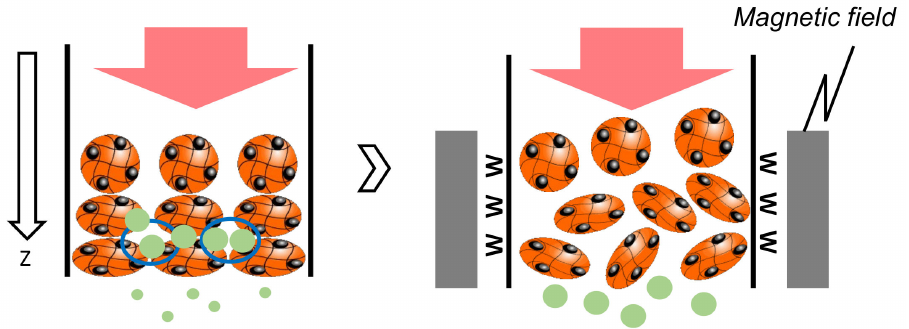
Figure 1. Dynamic Mag-gel bed by different magnetic fields for the separation of